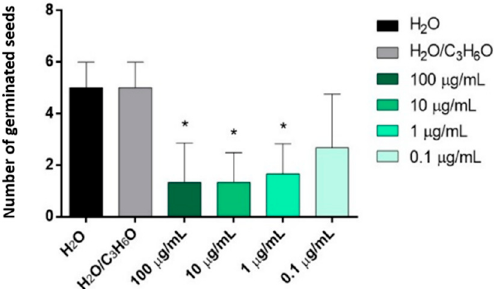
Figure 5. Phytotoxic activity of C. × bergamia (B) EOs against germination of P. oleracea, 120 h after sowing. Results are the mean of three experiments ± standard deviation. * p < 0.05 compared with control (ANOVA followed by Dunnett’s multiple comparison test).